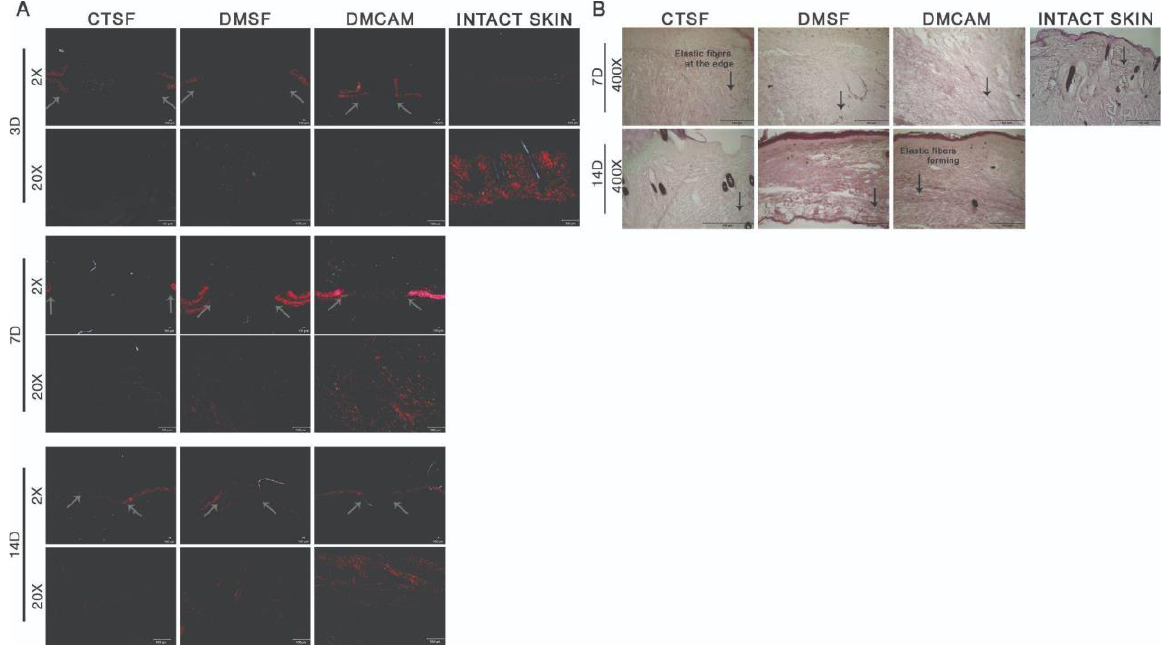
Figure 6. Reorganization of collagen fibers in neodermis after topical application with plasticized chitosan-alginate membranes and deposition of elastic fibers after the excisional wound. ( A ) skin fragments with wounds collected on days 3, 7, and 14 showing images representing birefringence of collagen fibers stained with Picrosirius red and analyzed under polarized light. Less enhanced grey arrows indicate the location where excisional wounds were performed. Enlargements of 2× and 20× , scale bar = 100 μm. All groups were compared with intact skin fragments stained with Picrosirius red (right side box). ( B ) Skin wound fragments collected after days 7 and 14 with images representing collagen fibers stained with the Weigert Resorsina-Fucsina method to identify elastic fibers. Less enhanced black arrows indicate the aspect of stained elastic fiber. Enlargements of 400×; scale bar = 100 μm. All groups were compared to intact skin fragments (G) stained with Weigert Resorsina-Fucsina (right side box).